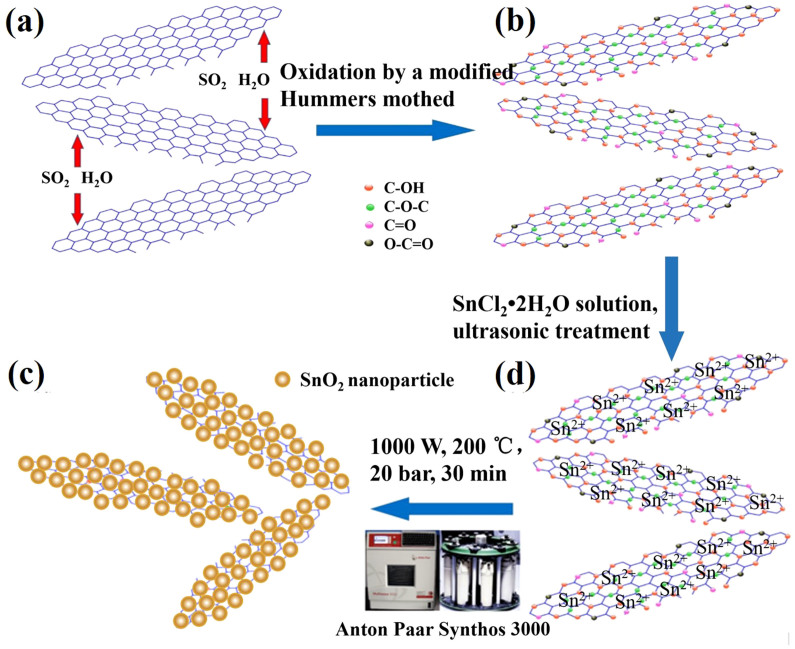
Schematic representation of the fabrication process of SnO2/graphene.(a) Expanded graphite, (b) Graphene oxide, (c) Graphene oxide and SnCl2·2H2O mixed solution and (d) SnO2/graphene composite.